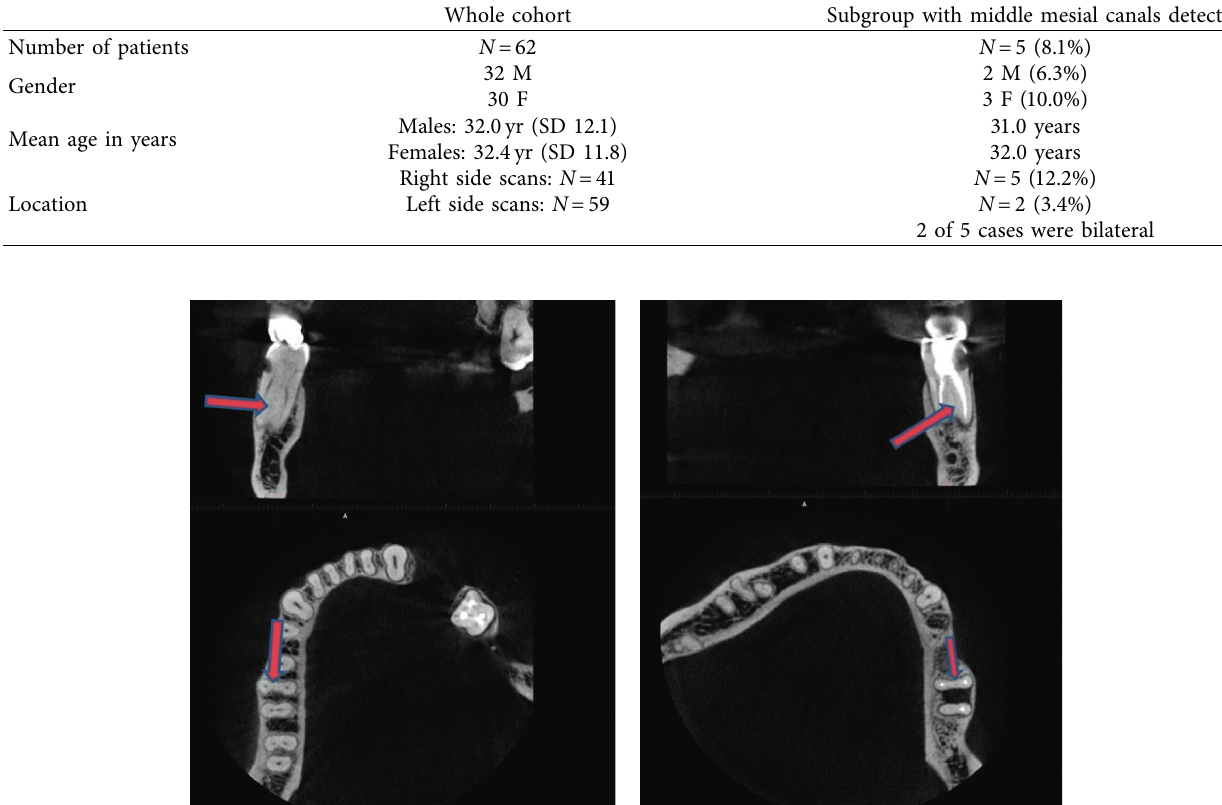
Table 1: Demographics of the whole cohort and subjects with MMC.